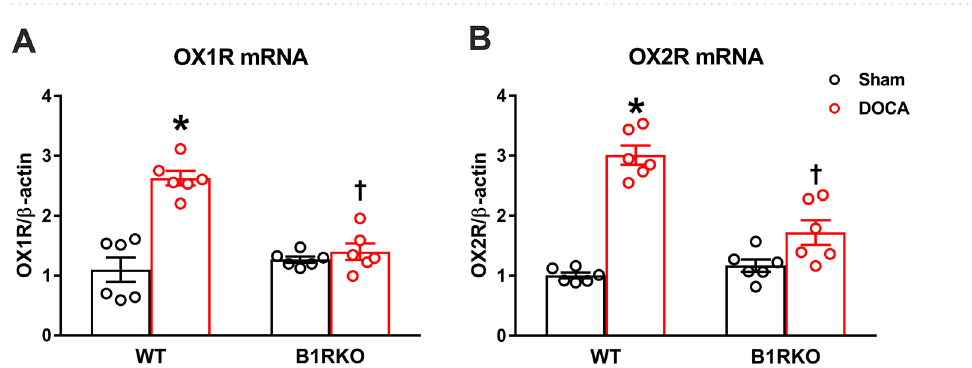
Figure 2. Gene expression of orexin receptors. DOCA-salt treatment significantly increased ( A ) OX1R and ( B ) OX2R mRNA in the brain hypothalamic PVN of WT mice, which was prevented in B1RKO mice with DOCA- salt hypertension. Statistical significance: Two-way ANOVA followed by Tukey’s multiple comparisons test. * p < 0.05 versus WT + Sham; † p < 0.05 versus WT + DOCA; n =